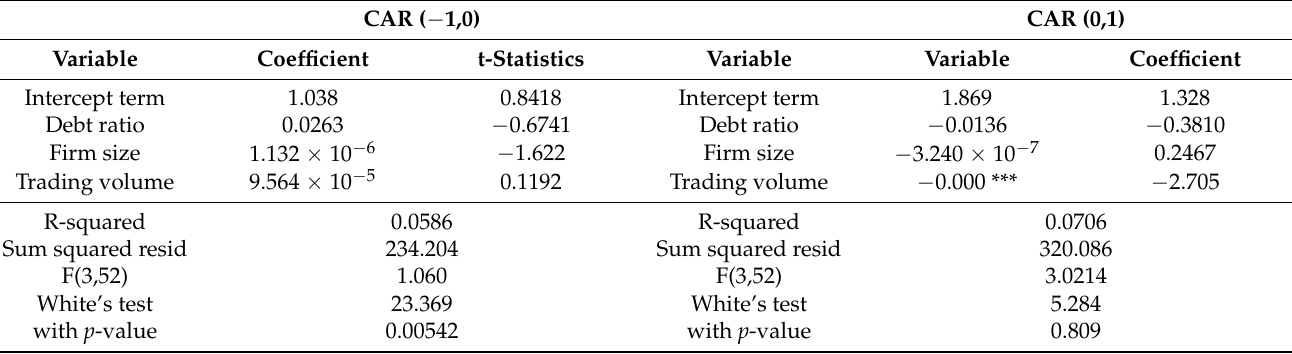
Table 4. Cross-sectional multiple regression analysis of IC design houses in patent lawsuits. Unit: Percentage